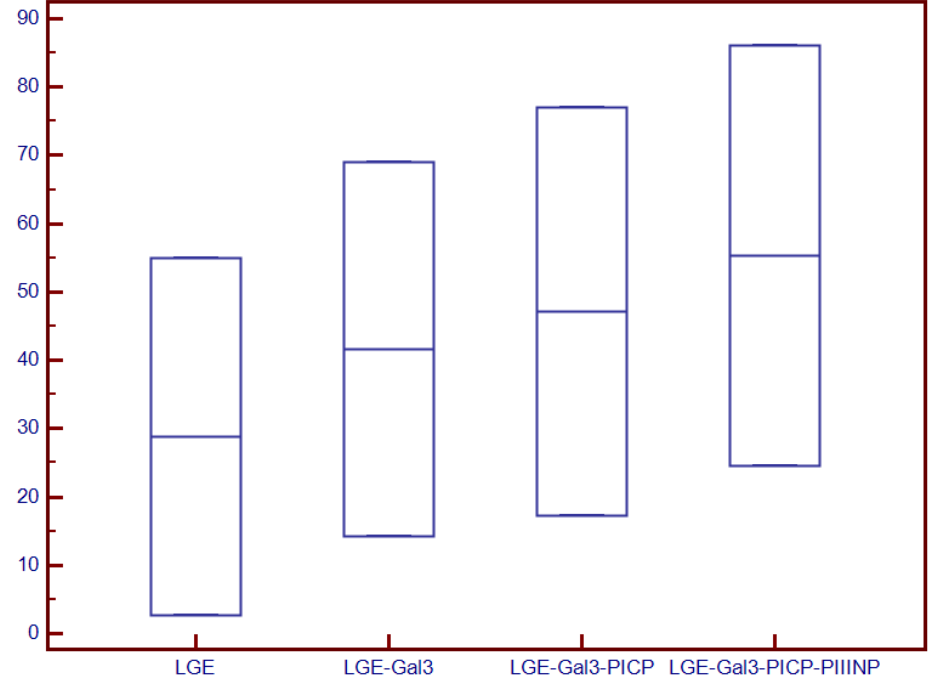
Figure 3. Incremental ability of LGE, LGE stepwise added to Gal-3, PICP and PIIINP for identifying patients with NIDCM and severely decreased LVEF. Abbreviations: Gal-3, galectin-3; LGE, late gadolinium enhancement; PICP, procollagen type I carboxy-terminal pro-peptide; PIIINP, N-terminal pro-peptide of procollagen type III; ROC, receiver operating characteristics.